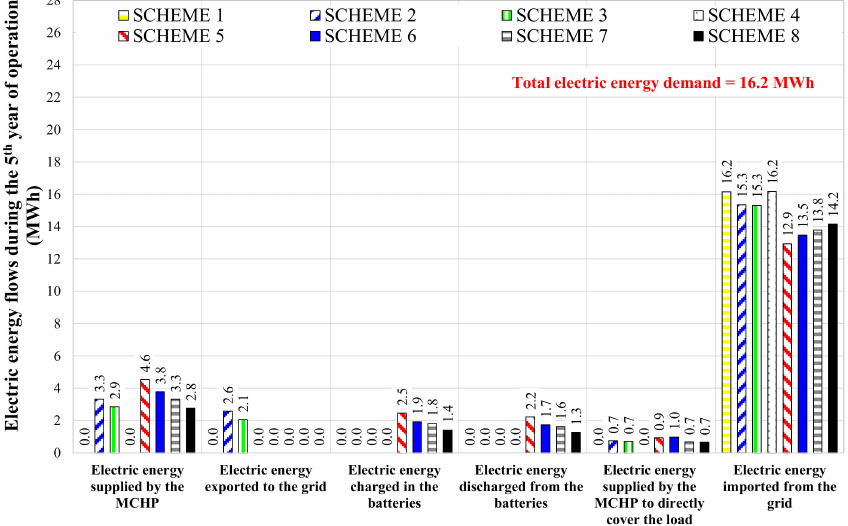
Figure 11. Electric energy flows during the fifth simulation year as a function of the system